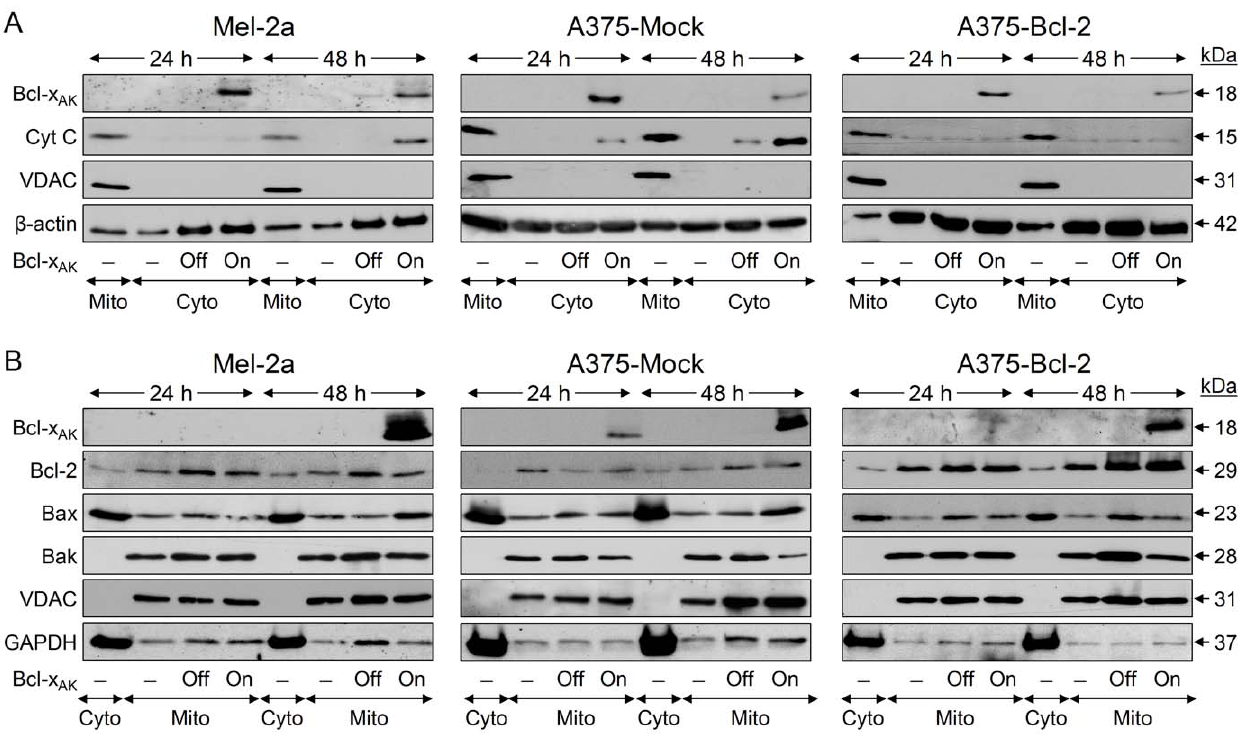
Figure 6. Bcl-2 blocks Bcl-x AK -mediated cytochrome c release and Bax translocation. Mel-2a, A375-Mock and A375-Bcl-2 cells were transduced with AdV-AK (MOI=50) and were kept under OFF and ON conditions. At 24 h and 48 h, cytosolic fractions (Cyto) and mitochondrial fractions (Mito) were isolated and analysed by Western blotting. Non-transfected controls ( 2 ) are shown as controls. The whole experiment was performed two times, resulting in highly comparable results. (A) Cytosolic extracts were analyzed for showing expression of Bcl-x AK and release of cytochrome c. Mitochondrial extracts serve as positive controls, the mitochondrial protein VDAC ruled out any contaminations of cytosolic extracts with mitochondria, and b -actin served as loading control. (B) Mitochondrial extracts were analyzed for showing mitochondrial translocation of Bcl-2 proteins. Here, cytosolic extracts served as controls, equal protein loading was confirmed by VDAC and the relative purity of mitochondrial extracts was examined by GAPDH. 5% of the total mitochondrial fractions and 2% of the total cytosolic fractions had been loaded on the